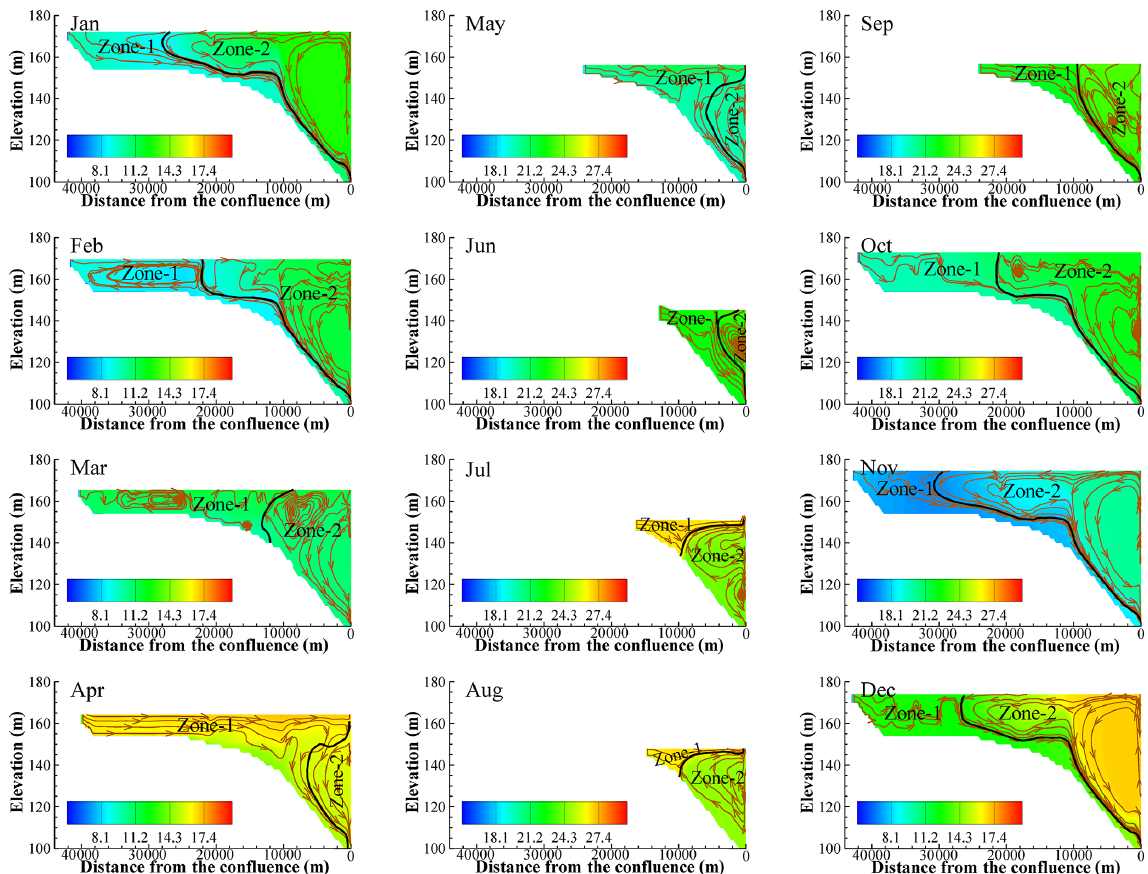
Figure 9. Distribution of water temperature in different months. The black curve in the figure is the boundary between zone 1 and zone 2. The brown curves with arrows are